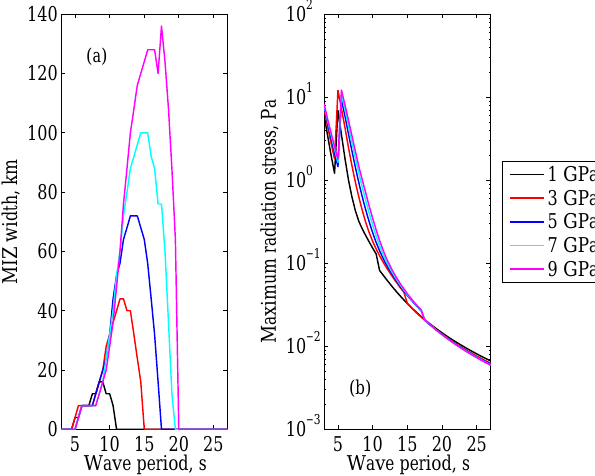
Figure 4. Variation of MIZ width (a) and maximum WRS (b) with peak wave period and Young’s modulus. Dashed curves: Pierson–Moskowitz spectra are used for the forcing. Solid curves: Bretschneider spectra are used with the significant wave height be- ing 4m. The concentration was 0.7, the thickness was 1m, and the small-scale cohesion used was 629kPa. The WIM is not coupled to neXtSIM.